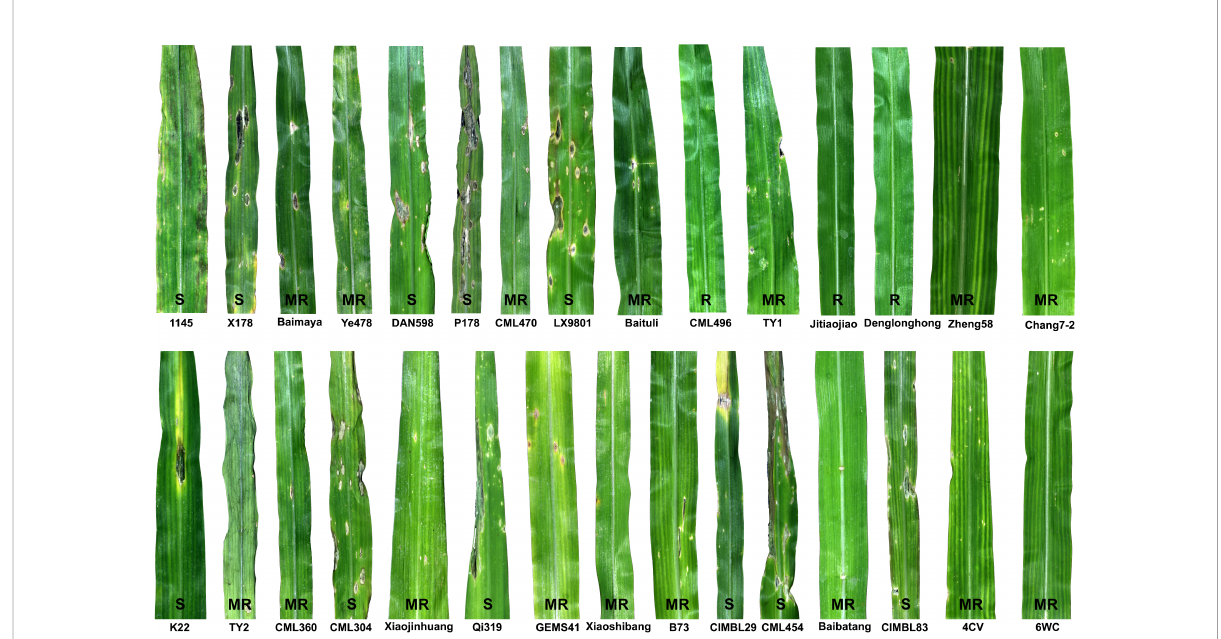
FIGURE 4 Maize germplasm screening to identify the genetic sources of resistance to Didymella leaf blight caused by Didymella glomerata . Fourth leaves of thirty lines (cultivars, inbred lines and landraces) at the V3 stage were spray-inoculated with conidial suspension (1 x 10 7 conidia/ml in 0.025%) until runoff. Three of the lines expressed complete resistance (R; no lesion) to D. glomerata , followed by respectively sixteen and twelve lines exhibiting moderate resistance (MR; few con fi ned scattered lesions) and susceptible (S; coalesced lesions) reactions. An augmented randomized complete block design was used to evaluate the maize germplasm for DLB resistance. The leaves were photographed fi ve days